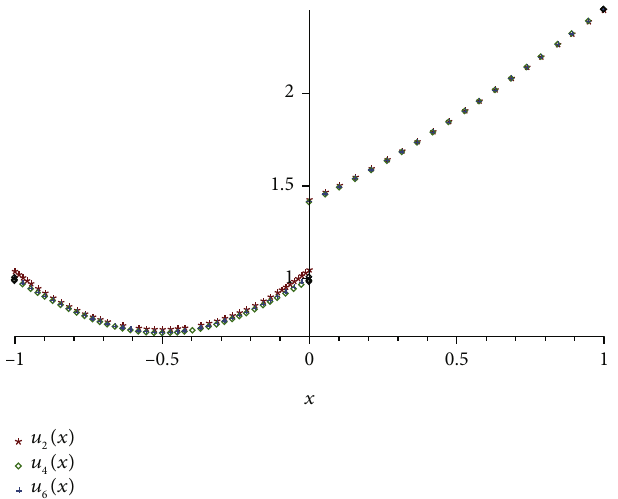
ð x Þ , u ð x Þ , ð x Þ for Example 7. 2 4 6